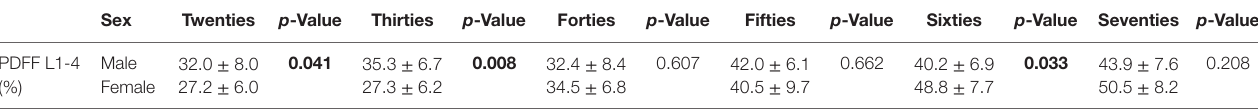
TaBle 2 | Mean ± SD of proton density fat fraction (PDFF) averaged over L1–4 for each age group.